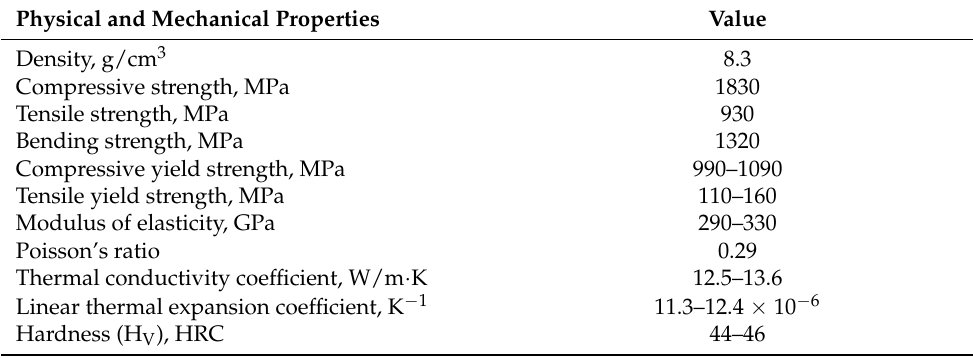
Figure 1. A sample of a composite metal matrix material obtained from a powder mixture of Inconel 625 + 5 wt.% NiTi-TiB2 by direct laser deposition: appearance ( a ), X-ray pattern of the material ( b ), SEM image of the structure ( c – e ), histogram of the distribution of TiB2 particles by size. Table 3. Physicomechanical properties of the Inconel 625 composite with added NiTi-TiB 2 .